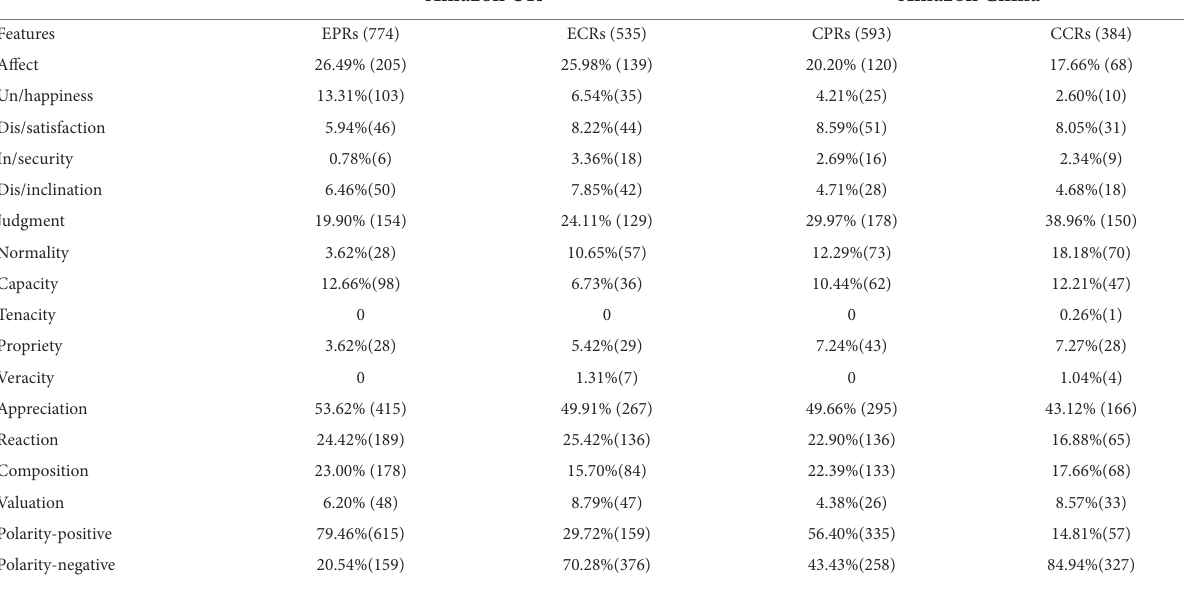
TABLE 2 Distribution of attitude resources in Chinese and English Amazon consumer